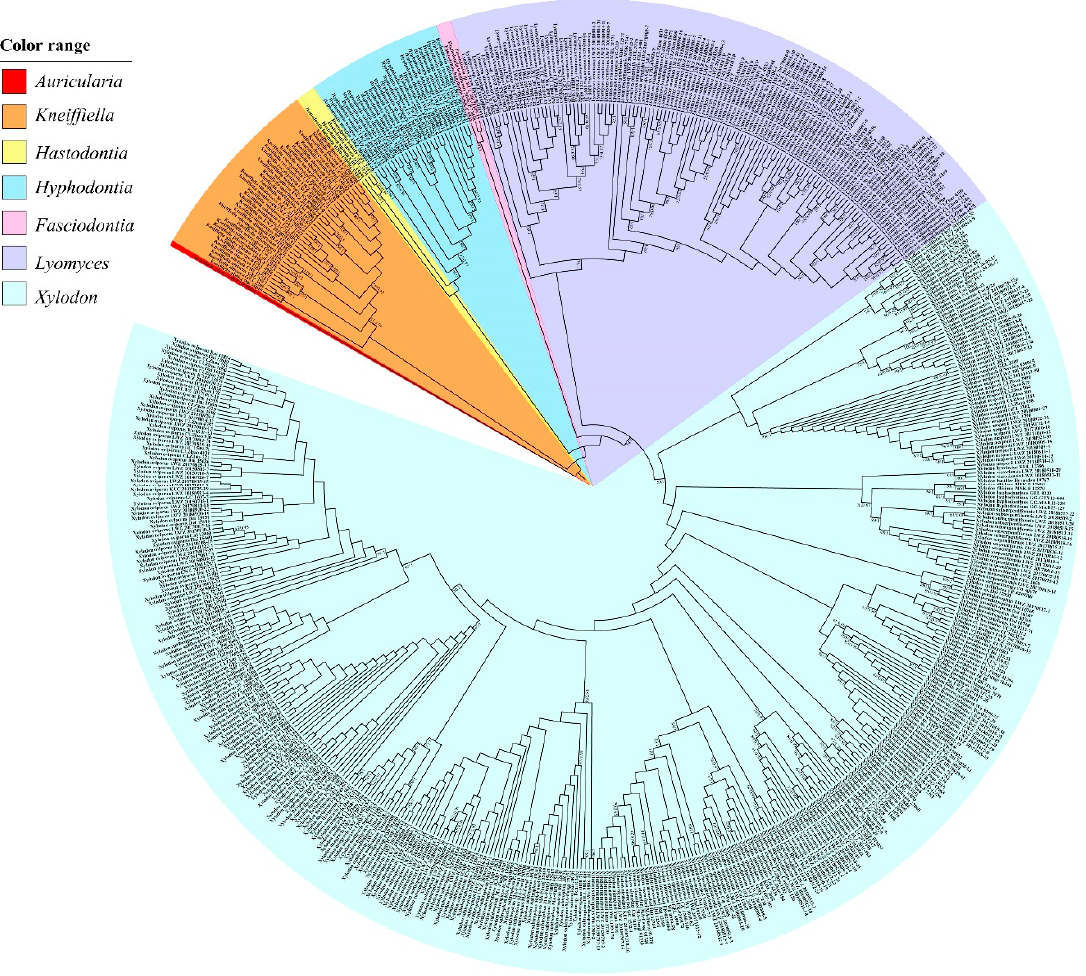
Figure 1. Identity of species belonging to Hyphodontia sensu lato differentiated by ITS-based phylogeny. The tree generated by the maximum likelihood algorithm is presented along with the bootstrap values and the Bayesian posterior probabilities above 50% and 0.8, respectively, at the nodes. The genus represented by each color is indicated in the upper-left of the tree.